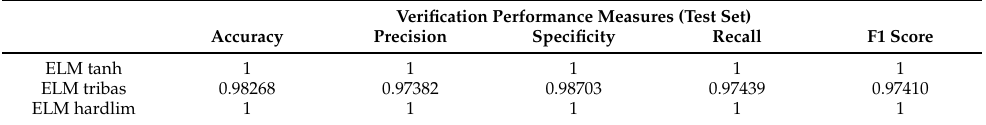
Table 17. Additional classification performance measures in the training set (validation step) using three different transfer functions of the ELM algorithm in dataset #3 (corresponding to k = 50 , min_dist = 0.5, d = 8, ˜ d =